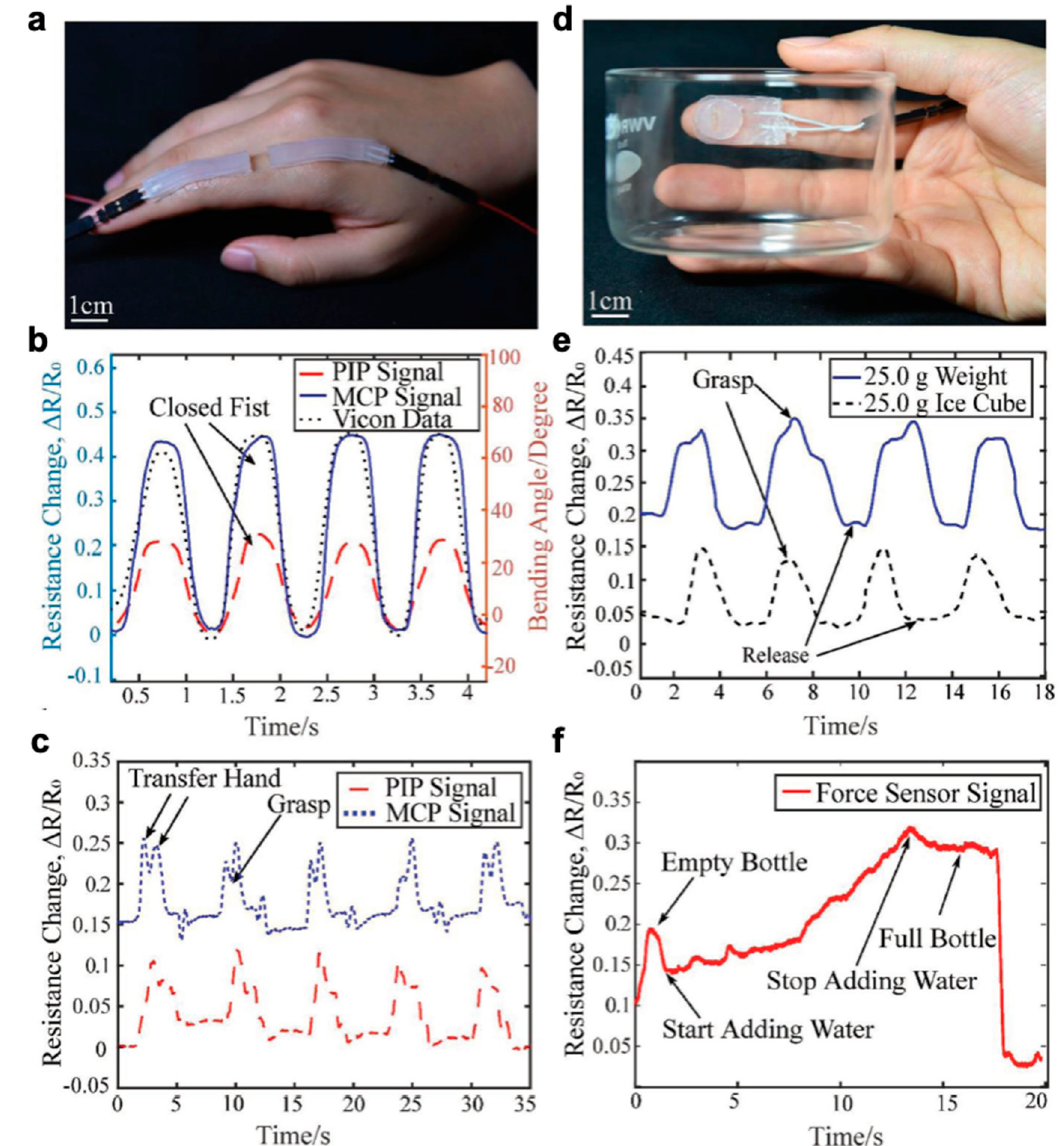
Figure 13. Demonstration of various functionalities as wearable sensors for hand motion detection with strain sensing along the proximal interphalangeal (PIP) joint and metacarpophalangeal (MCP) joint ( a – c ) and force sensing at the index fingertip for picking up items of different temperature ( d,e ) and force sensing of dynamic motions ( f ). Reproduced with permission from [234]. Copyright 2018 John Wiley and Sons.